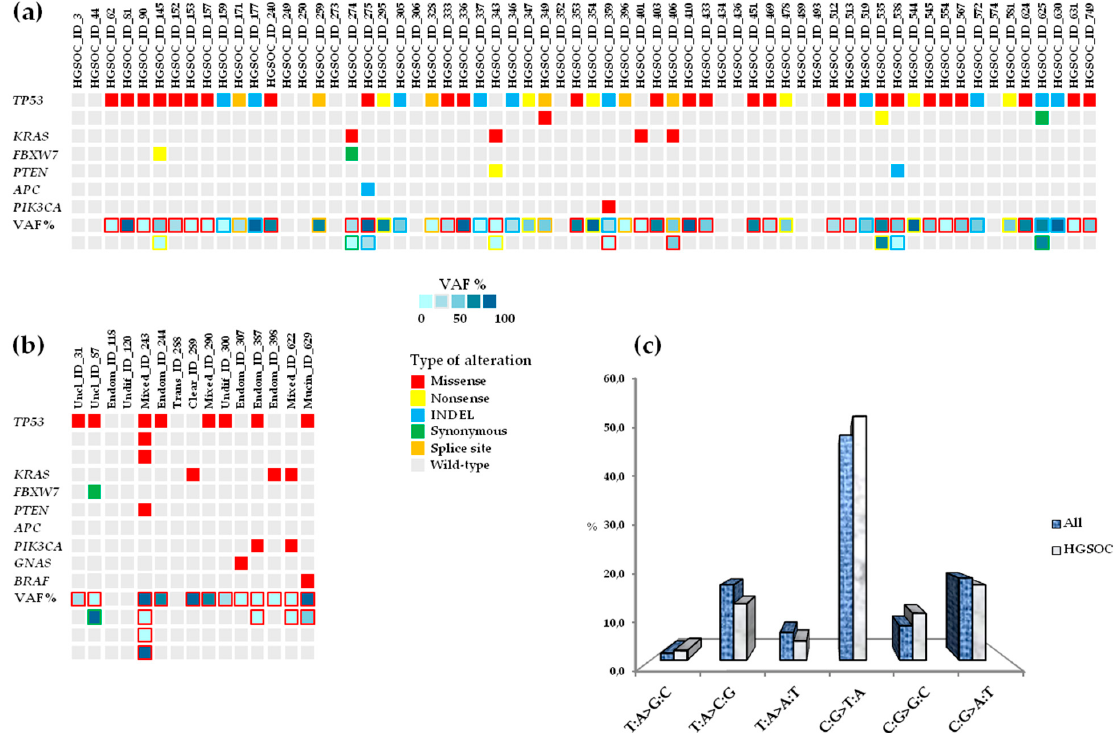
Figure 1. Mutational landscape in advanced ovarian tumors (n = 79) by NGS. ( a ) Somatic profile in HGSOCs (n = 64). ( b ) Somatic profile in non-HGSOCs (n = 15). ( c ) A bar graph represents the single-nucleotide variants (SNVs) found in advanced ovarian tumors. VAF: variant allele frequency; INDEL: insertion or deletion leading to in-frame or frameshift change; HGSOC: high-grade serous ovarian cancer; Uncl: unclassified; Endom: endometrioid; Undif: undifferentiated; Trans: transitional; Clear: clear cells; Mucin: mucinous.